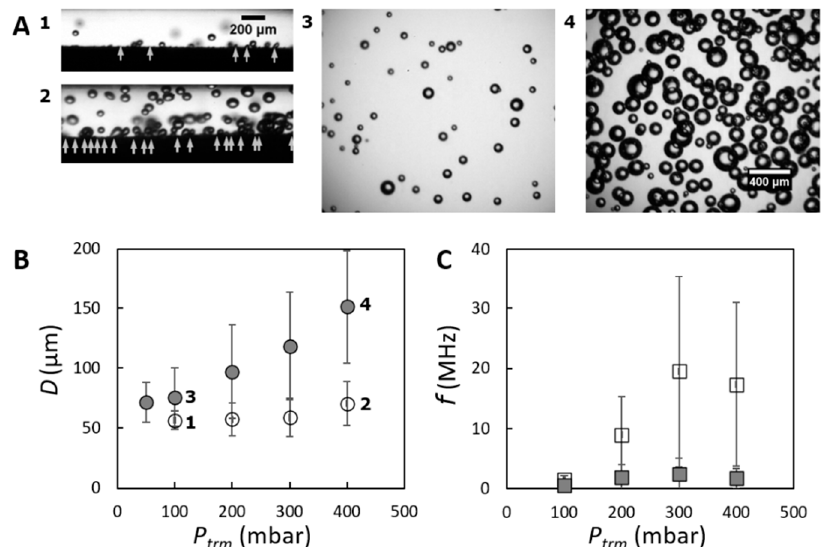
Figure 3. Bubble formation as function of transmembrane pressure, P trm (at constant Q c = 1.5 × 10 − 5 m 3 /s and c = 1 wt %). ( A ) Snapshots of bubble behavior obtained when using different transmembrane pressures (low—1,3 and high—2,4): 1,2—visualization of bubble formation at the membrane surface in the module; 3,4—visualization of bubbles that are flowing through the flow cell (10 cm downstream). It is noted that in 1,2, only pores located at a single tangent line of (part of) the membrane are in our focal plane, while in 3,4 bubbles formed from the whole membrane surface (circumference and length) are present. In 1,2, the arrows roughly indicate the position of active pores. ( B ) Bubble sizes D 0 and D coal , with a typical CV of ~20% and ~40%, respectively. ( C ) Bubble formation frequencies. The large error bars reflect the width of the size distribution, yet they are expected to be much smaller when studying individual pores. The bubble sizes (and the corresponding formation frequency) are indicated with two different symbols: D 0 ( f 0 )—unfilled circle (square) and D coal ( f coal )—filled circle